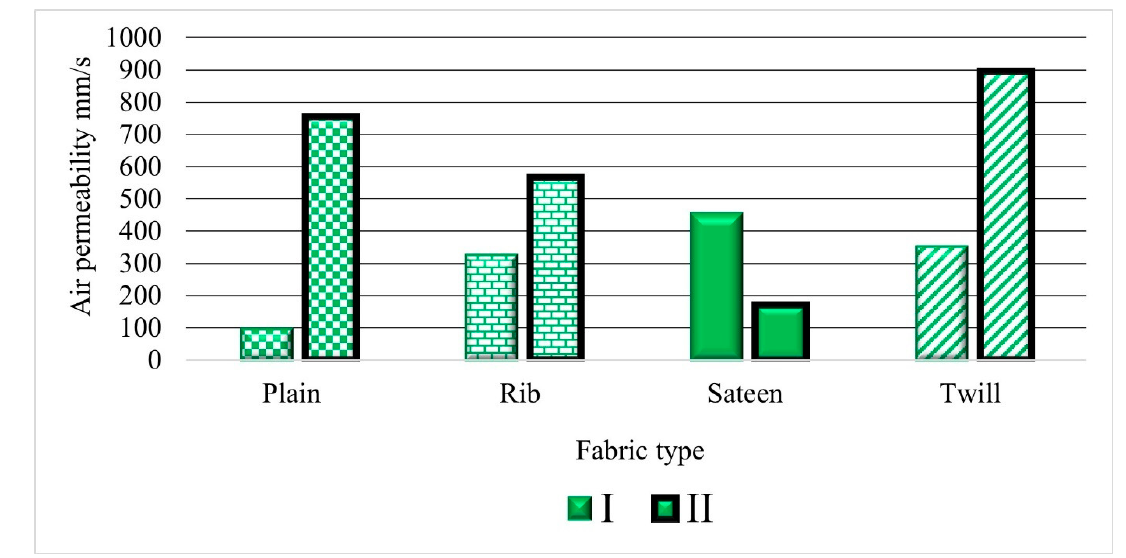
Figure 7. Comparisons based on yarn and weave parameters. Textured yarn (I) and textured yarn (II).